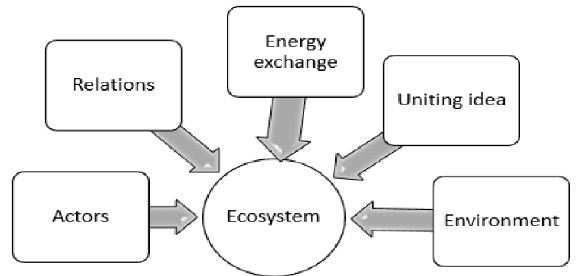
Figure 1. Main components of an ecosystem.